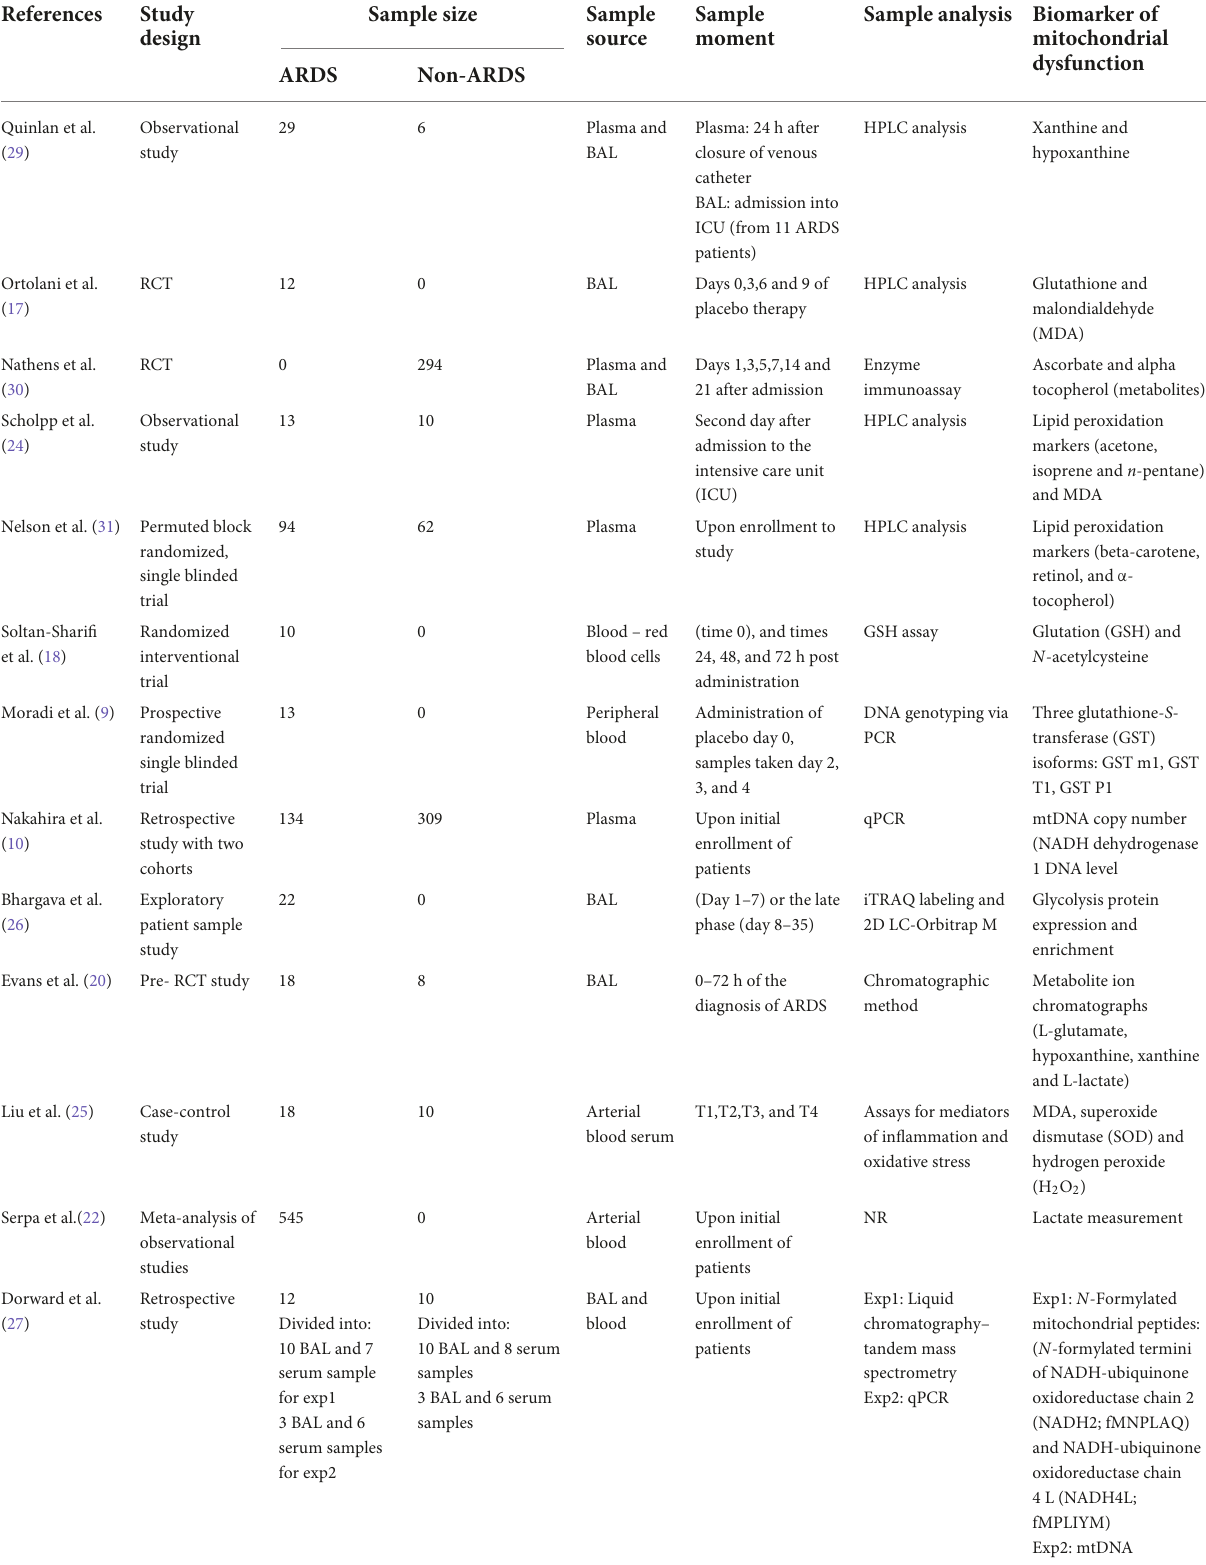
TABLE 3 Summary of study